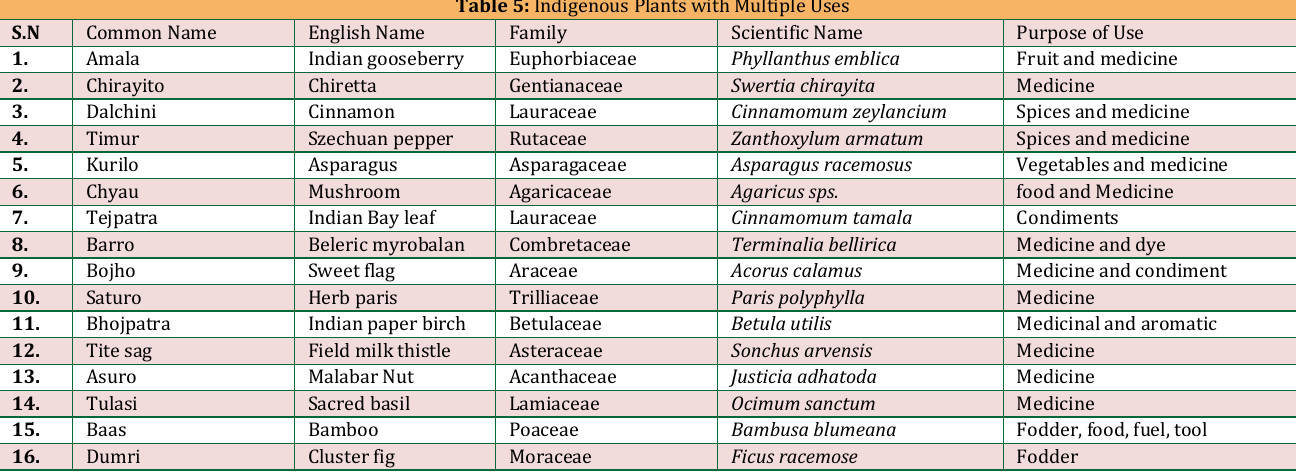
Table 5: Indigenous Plants with Multiple